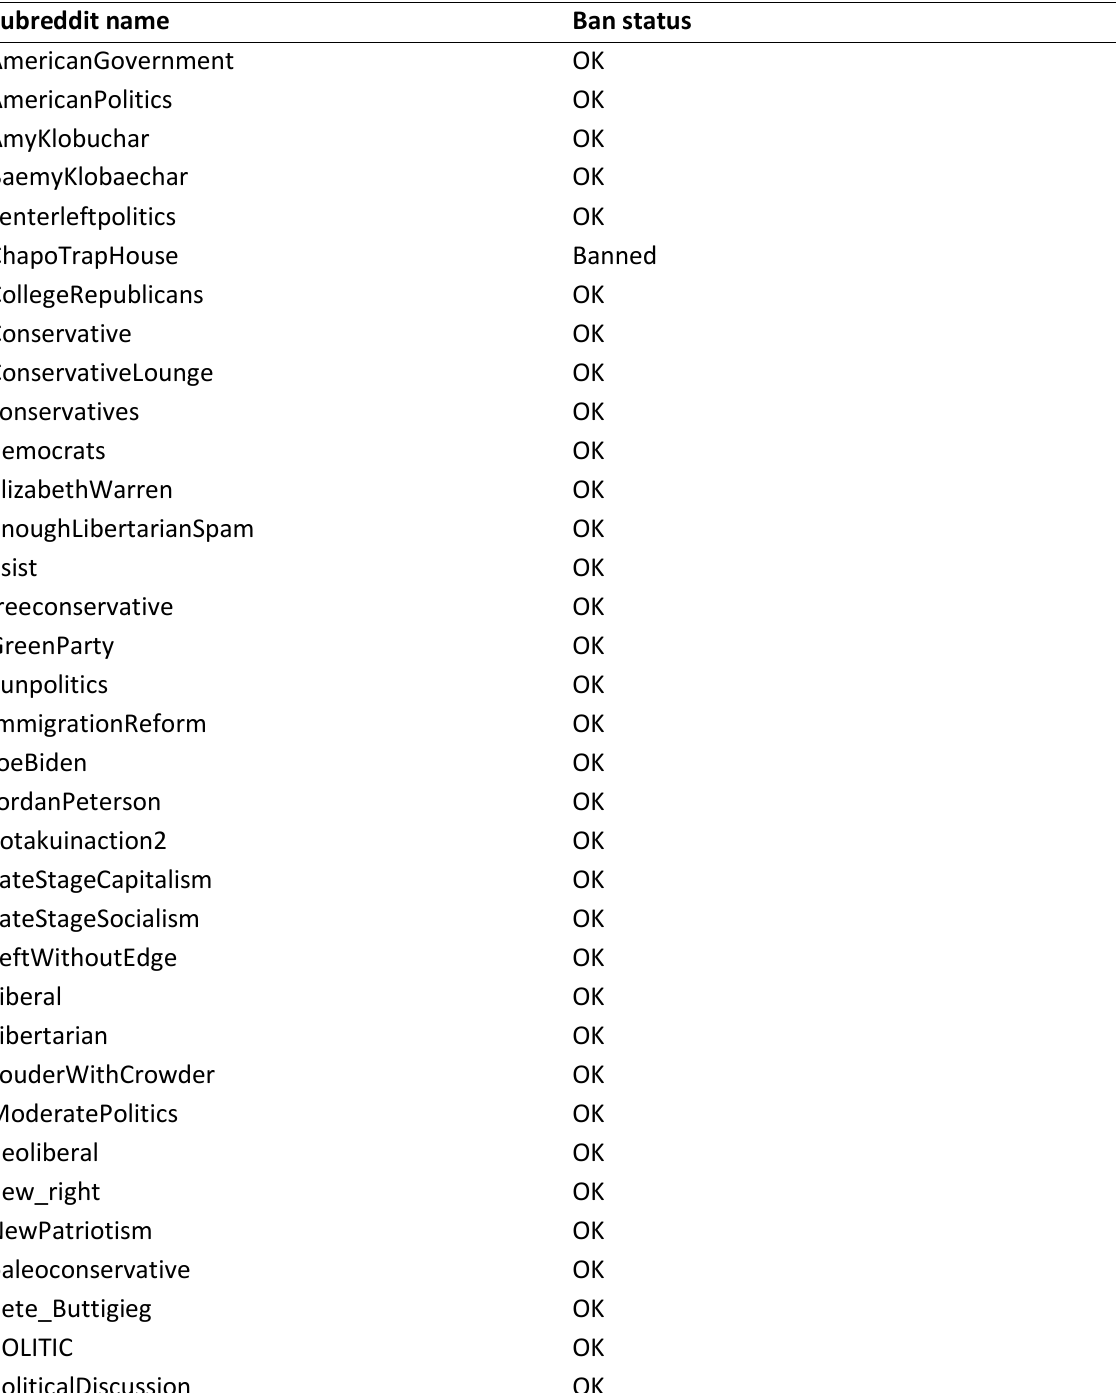
Table A. List of subreddits used in study and ban status after June 2020